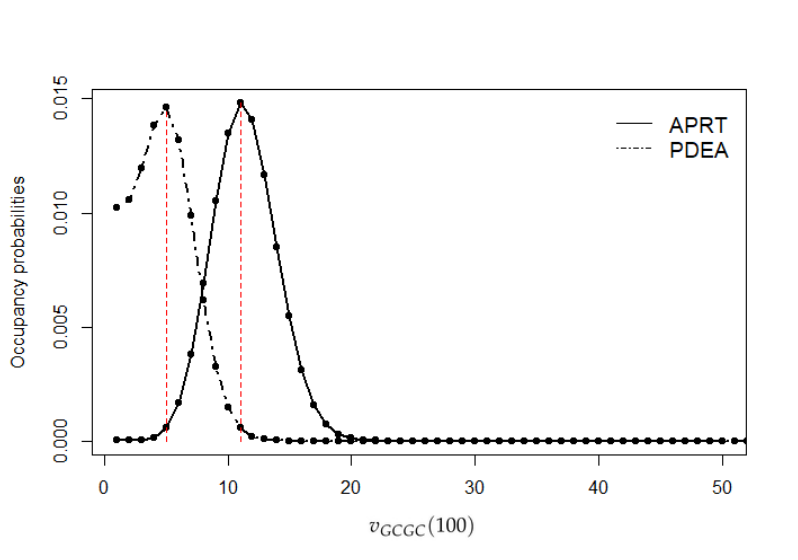
Figure 2. Occupancy probabilities of APRT and PDEA